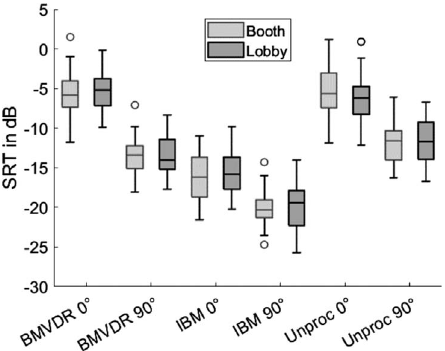
Figure 5. Boxplots of measured SRTs for each condition.